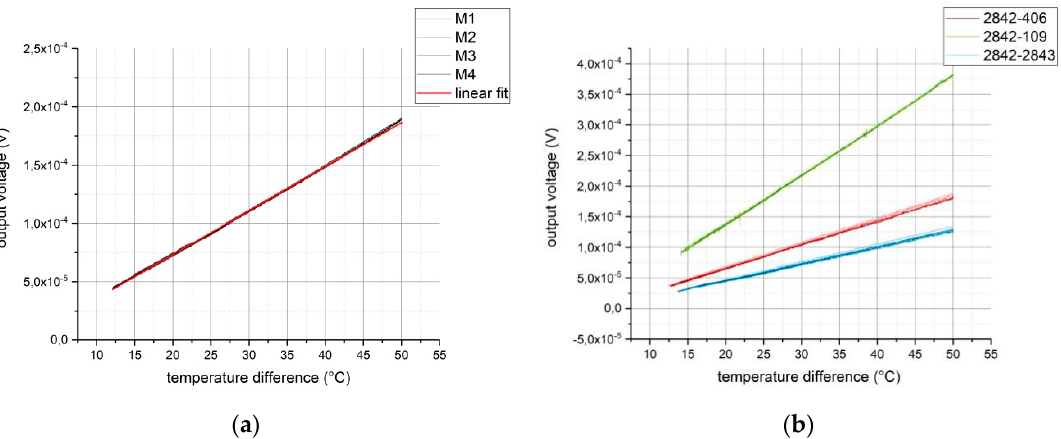
Figure 5. ( a ) Output voltage as a function of temperature difference between junction and connection. Four measurement cycles, M1-M4 (black), of the 2842-gold thermocouple and the corresponding linear fit (red); ( b ) output voltage as a function of temperature difference: outputs of thermocouples 2842-406 (red), 2842-406 (green), and 2842-2843 (blue). Each thermocouple was tested in four measurement cycles. Table 2. Materials used and their Seebeck coefficients and additional values of typical thermoelectric materials for comparison.